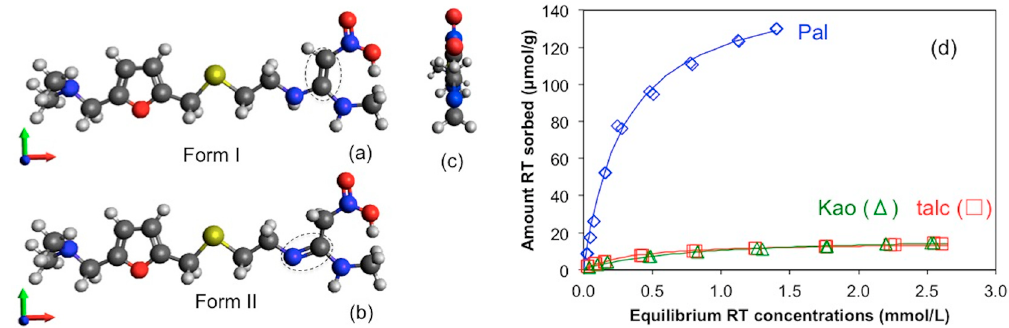
Figure 1. Molecular structure of ranitidine with ( a ) form I and ( b ) form II, and ( c ) their side view. The yellow is S, red is O, blue is N, dark gray is C, and the light gray is H. ( d ) Sorption of ranitidine (RT) on clay minerals.